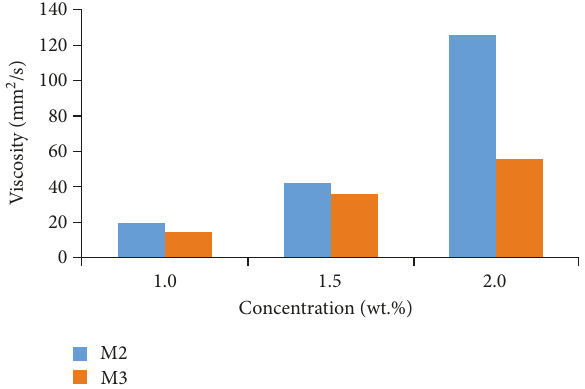
Figure 9: The viscosity of M2 and M3 chitosan solution in different concentrations. Compared with the morphology particles of M3 chitosan solution from 1.0 wt.% to 2.0 wt.% concentration, the nano- particles of M3 chitosan 1.5 wt.% concentration displayed more